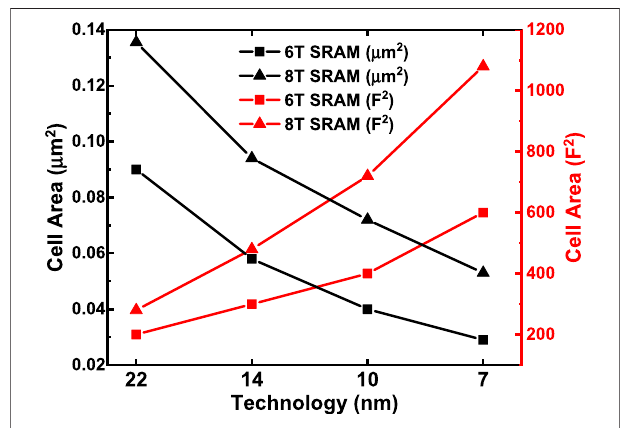
FIGURE 5 | I d -V g comparison of PTM model and TSMC PDK in (A) linear-scale and (B) semilogarithmic scale.